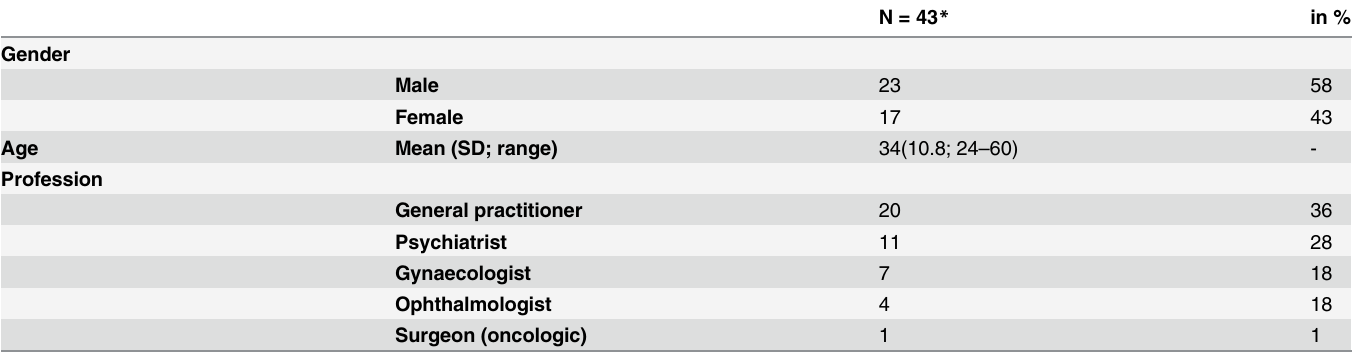
Table 2. Sample Characteristics of the Physicians.